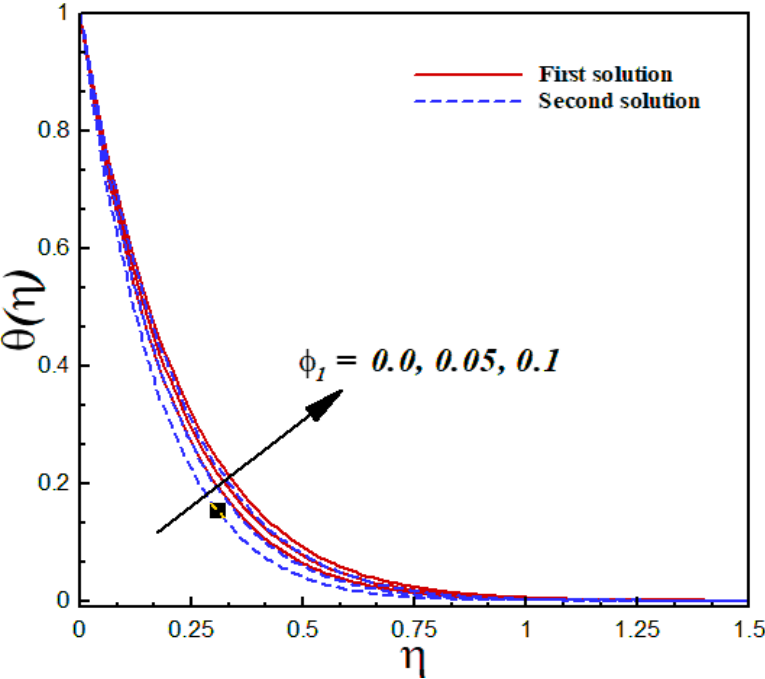
Figure 15. Temperature profiles θ ( η ) for distinct δ when λ = − 1.9, k 1 = 1 = γ = s , ϕ 1 = 0.1 = ϕ 2 , Pr = 6.2.